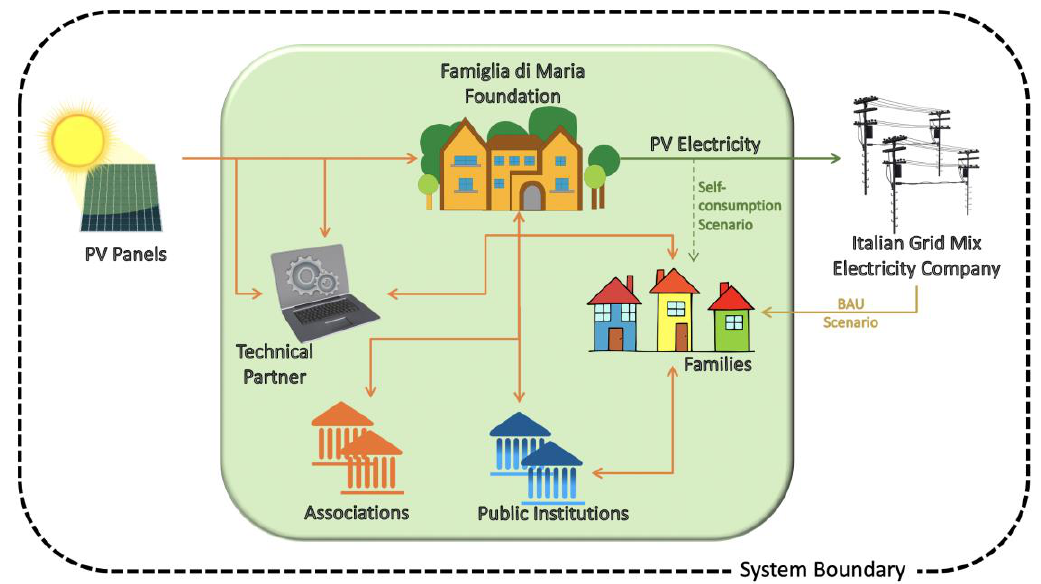
Figure 2. The system boundary of the investigated Solidarity Oriented REC of San Giovanni a Teduccio.